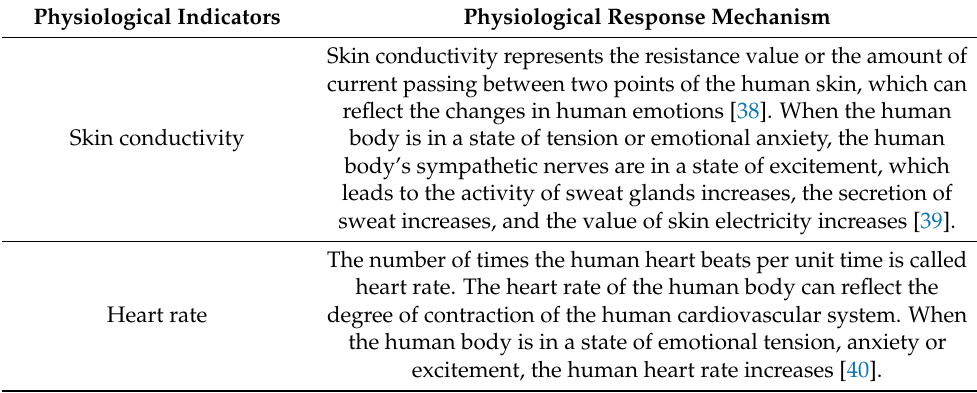
Table 4. Physiological measurement indicators and response